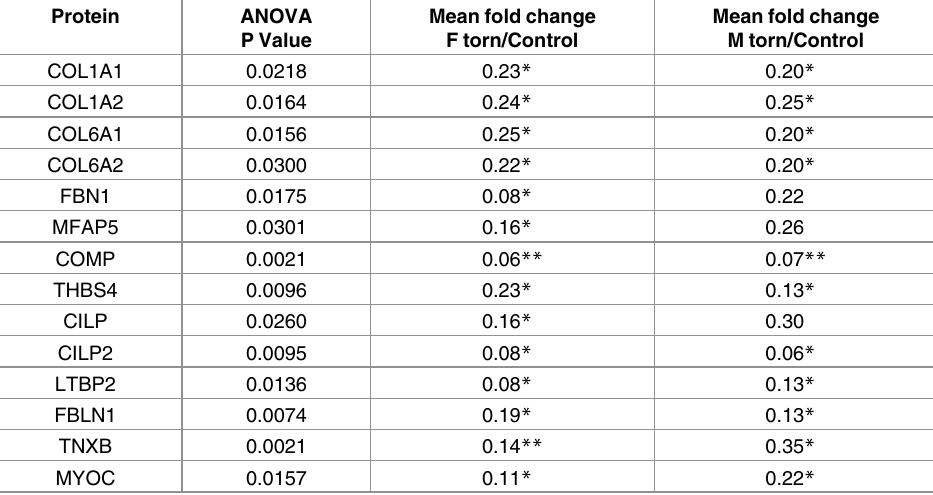
Table 3. The ANOVA P value and mean fold change of differentially expressedextracellular proteins in the torn tissue of female and male patients compared to control in the trypsin digested samples. ( * P < 0.05, ** P < 0.01, significantly different from control in post-test).